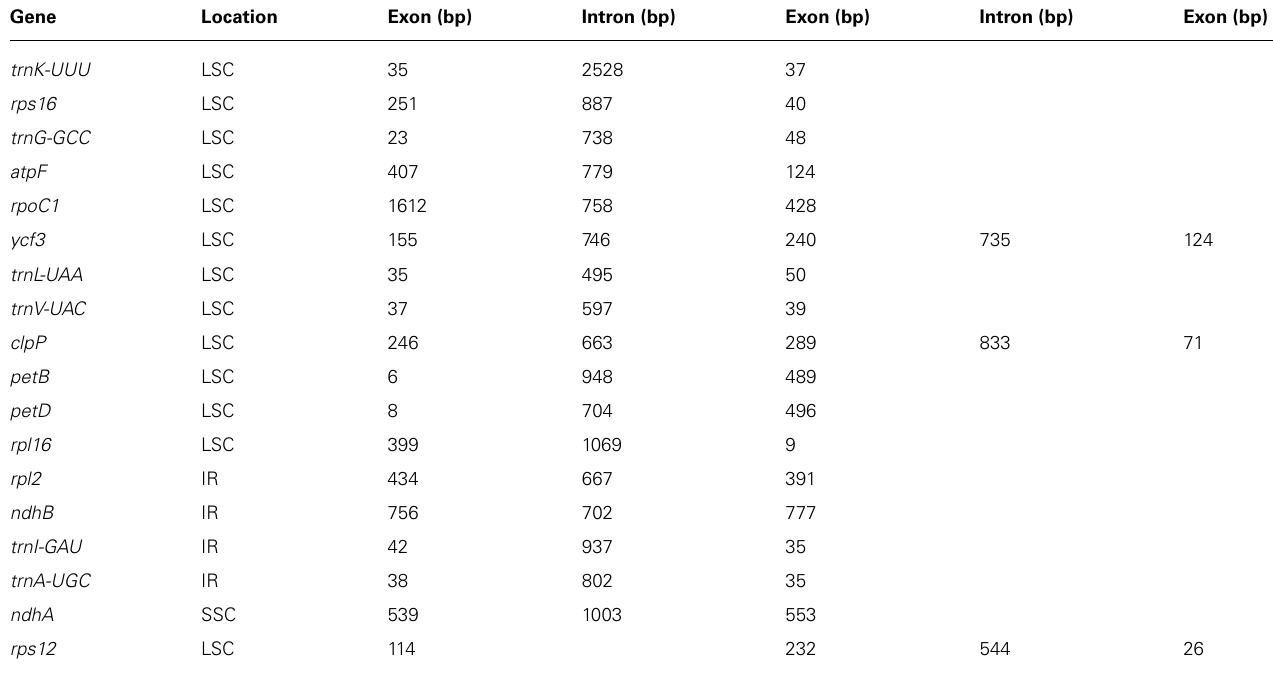
Table 3 |The genes with introns in the A. barbatum var. puberulum chloroplast genome and the length of the exons and